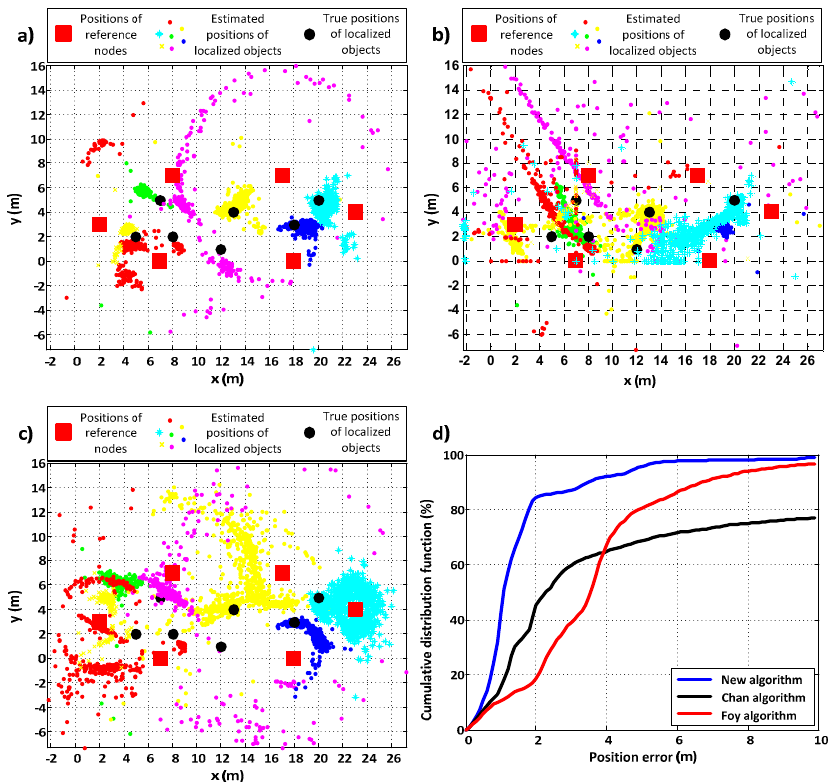
Figure 7. Comparative analysis of the performance of ( a ) the new algorithm, ( b ) the Chan algorithm, ( c ) the Foy algorithm, and ( d ) the cumulative distribution functions of position errors when all devices were deployed within one corridor, with assurance of good geometry.